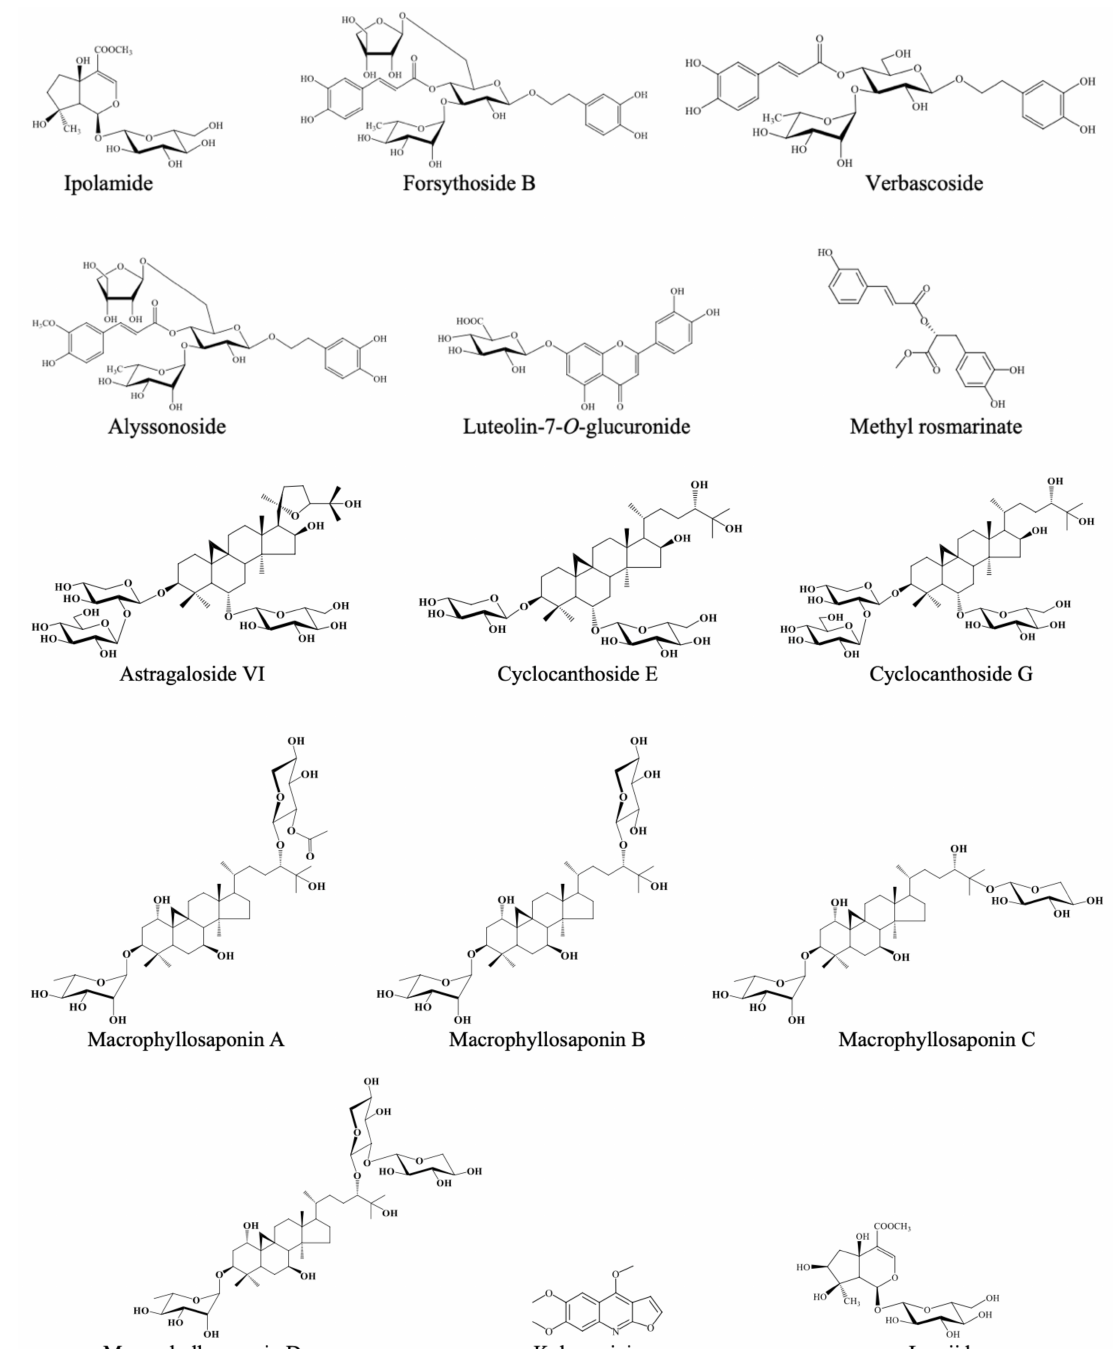
Figure 1. Chemical structures of the tested natural